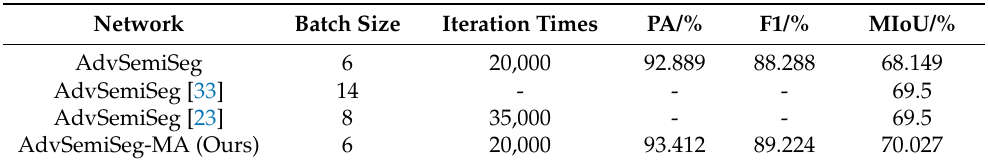
Table 5. Comparison of AdvSemiSeg methods and our method for segmentation on the VOC 2012